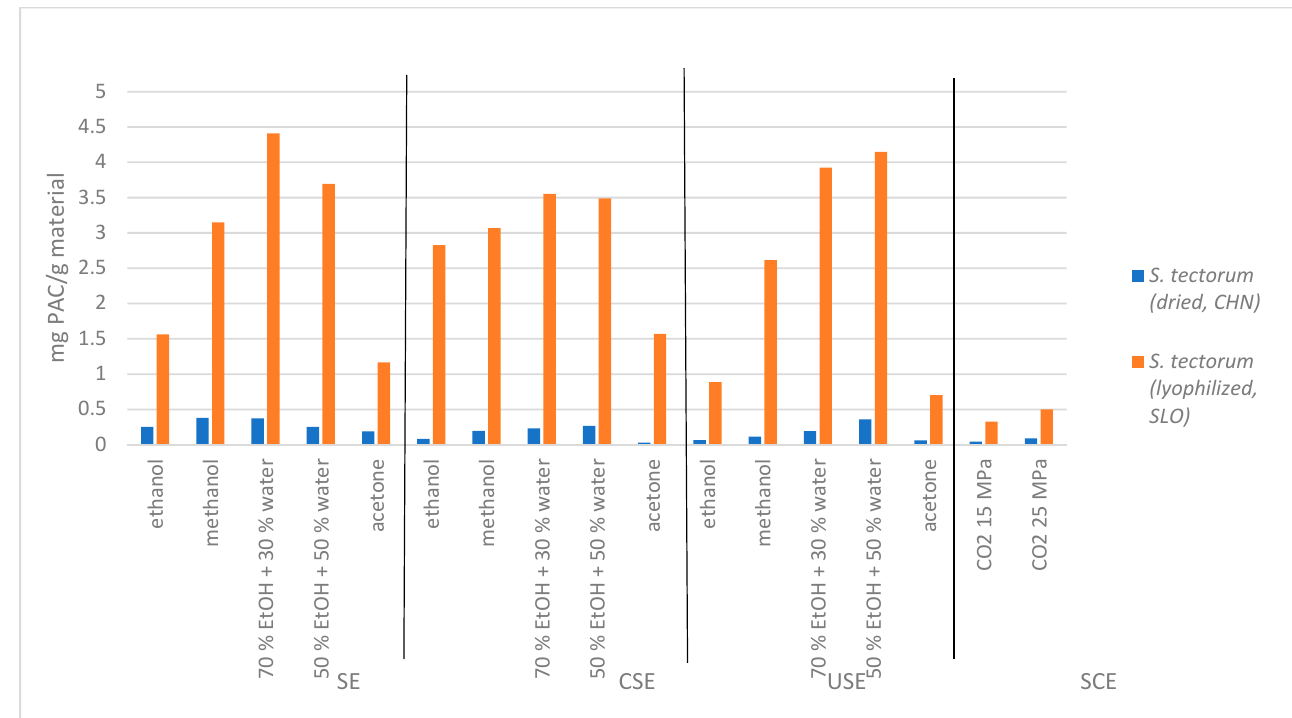
Figure 2. Proanthocyanidine content in S. tectorum extracts (SE, Soxhlet extraction; CSE, cold solvent extraction; USE, ultrasound extraction; SCE, supercritical extraction).